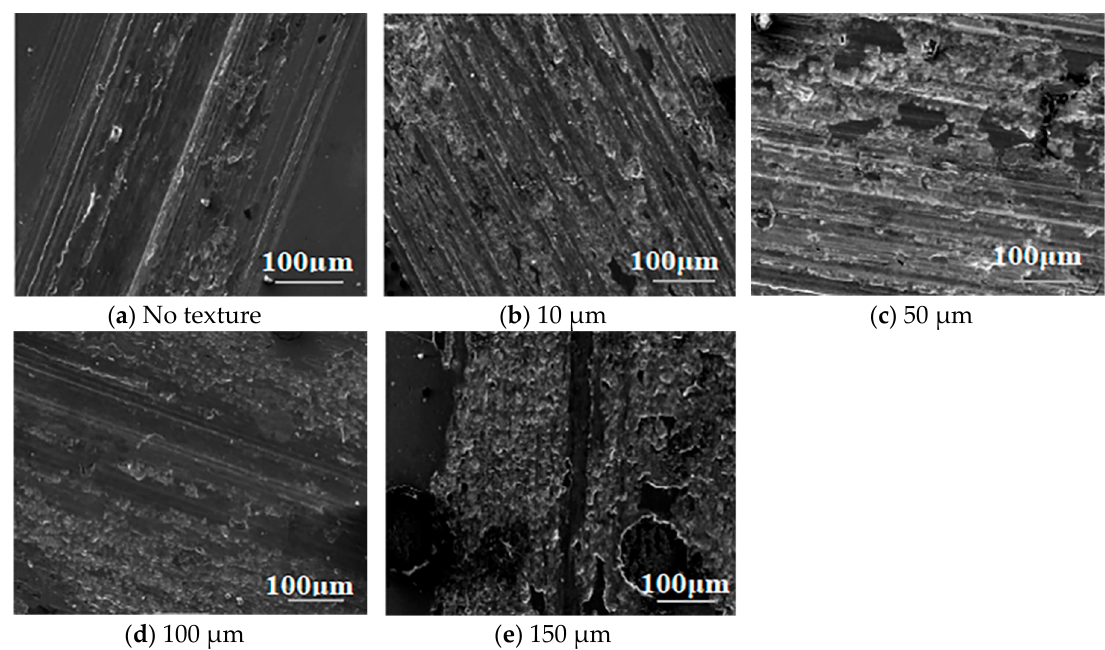
Figure 4. Microscopic morphology of wear scars of different pit diameters under dry friction.